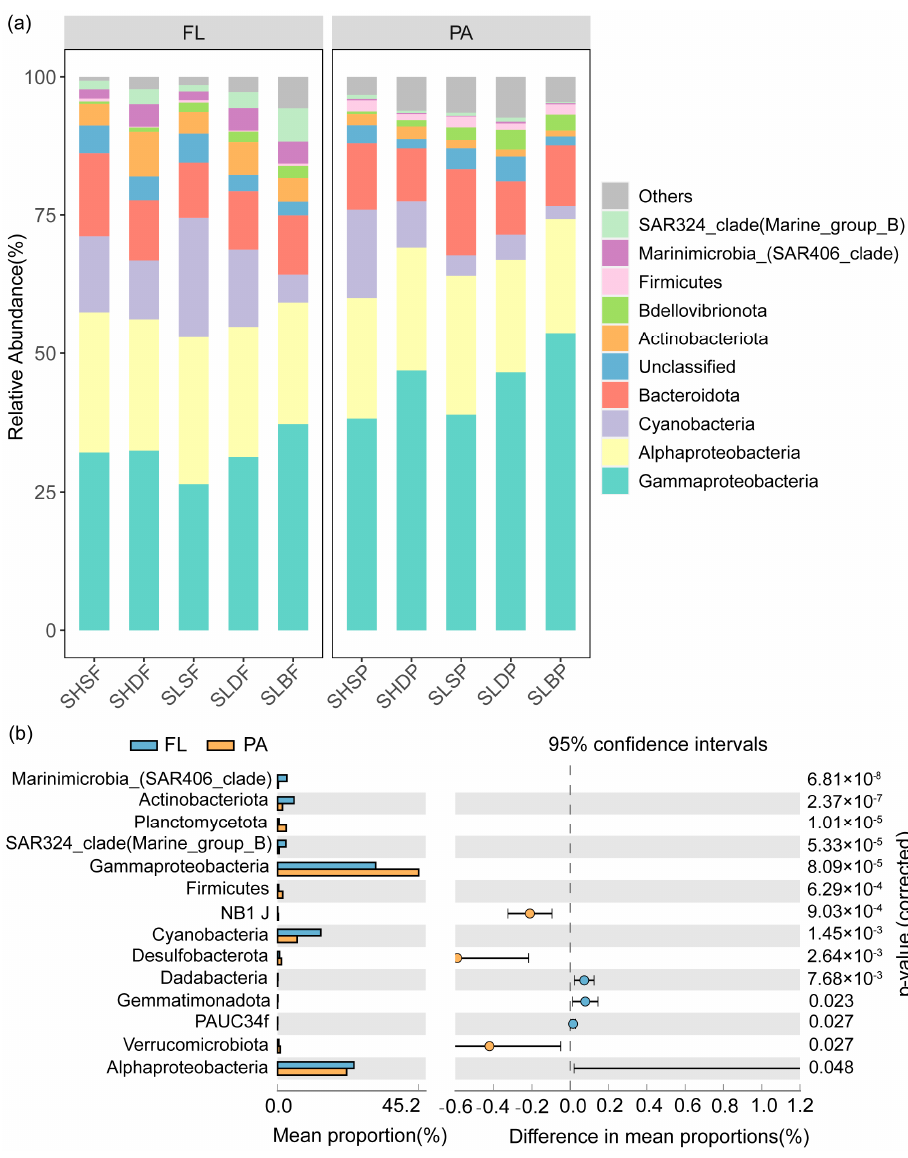
Figure 3. ( a ) Stacked bar chart showing relative abundance of the top 10 taxa during free-living and particle-associated communities. ( b ) Bacterioplankton phylums/classes with significantly different abundances between free-living and particle-associated communities. Besides, we also found similar phylum/subphylum distribution patterns across water depth between the FL and the PA communities (Figure S4). For example, Cyanobacteria decreased quickly with increasing water depth. By contrast, the relative abundance of Marinimicrobia_(SAR406_clade), SAR324_clade (Marine_group_B), Bdellovibrionota and Gammaproteobacteria showed continuous increases with increasing depth. The relative abundance of Firmicutes, Bacteroidota, Gammaproteobacteria, Bdellovibrionota and Al- phaproteobacteria were stable across all bacterioplankton communities, with no significant difference from each other (Figure S4). At the family level, the significantly higher abun- dances of Clade_I, SAR86_clade, Actinomarinaceae, Marinimicrobia_SAR406_clade and SAR324_calde (Marine_group_B) were found in the FL community than in the PA com- munity (Welch’s t -test, p < 0.05, Figure S5). The relative abundances of Actinomarinaceae, Marinimicrobia_SAR406_clade and SAR324_clade(Marine_group_B) in the FL community showed continuous increases with increasing depth. However, The relative abundance